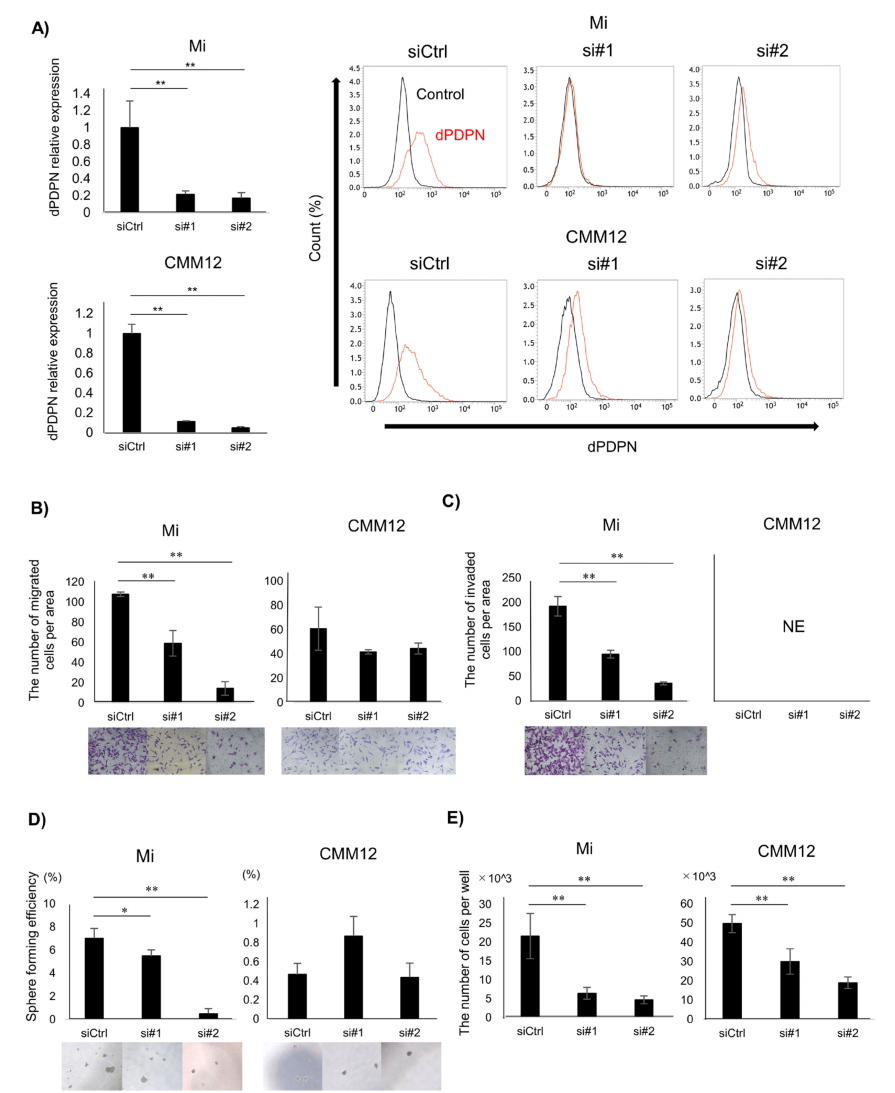
Figure 2. Investigating the association between dPDPN and tumor malignancy in canine MM cell lines. These experiments were performed in triplicate. ( A ) Left panel: dPDPN mRNA expression was evaluated by qPCR and (right panel) protein expression was evaluated by flow cytometry after 48 h of siRNAs treatment in Mi and CMM12 cell lines. ( B ) The number of migrated cells in control-scrambled siRNA, siRNA#1, or siRNA#2-treated Mi and CMM12 cell lines. Representative well images of each group are shown ( × 100). ( C ) The number of invading cells in control-scrambled siRNA, siRNA#1, or siRNA#2-treated Mi and CMM12 cell lines. Representative well images of each group are shown ( × 100). ( D ) Number of spheroids derived from control-scrambled siRNA, siRNA#1, or siRNA#2-treated Mi and CMM12 cell lines. Sphere forming e ffi ciency is calculated by dividing the number of spheroids by the number of seeded cells. Representative well images of each group are shown ( × 100). ( E ) Number of living cells of control-scrambled siRNA, siRNA#1, or siRNA#2-treated Mi and CMM12 cell lines after 48 h of siRNAs treatment. siCtrl: Control-scrambled siRNA, si#1: siRNA#1, si#2: siRNA#2, * p < 0.05, ** p < 0.01, not evaluated (NE), dog podoplanin (dPDPN). To investigate the association between dPDPN and cancer stemness, a sphere-forming assay was performed. The number of spheres developed from a single cell of the Mi cell line was significantly reduced following dPDPN-specific siRNAs treatment. On the contrary, dPDPN knockdown in CMM12 cell line did not reduce the number of spheres (Figure